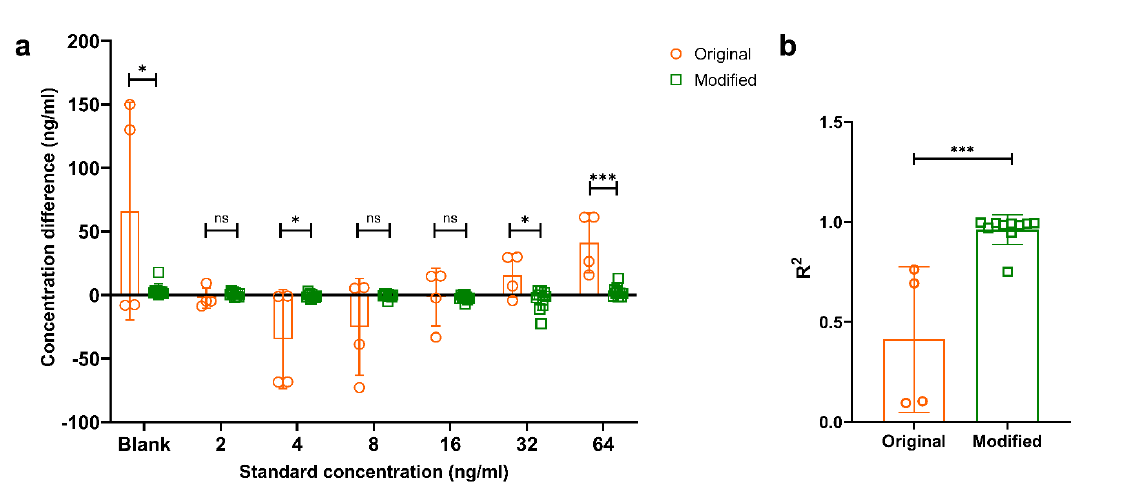
Figure 3: a. Concentration difference of standard solutions at each point; b. R 2 values. Values are given as mean ± standard deviation. Student’s t-test was used for statistical analysis. n=4, original kit protocol; n=10, modified kit protocol. ns, non-significant; *p < 0.05,